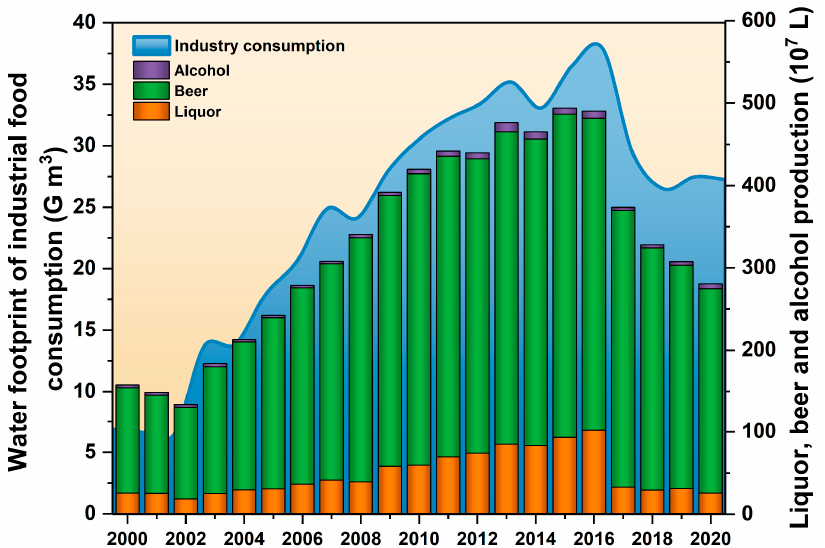
Figure 7. Water footprint of industrial grain consumption in Northwest China, 2000–2020. Note: The data of liquor, beer and alcohol in the statistical analysis results are shown according to volume. According to their density differences, we multiplied their volume unit values by 0.89, 1.0 and 0.8, respectively, into mass units. Industrial consumption involves liquor, beer, alcohol and side food. Their conversion coefficients to grain are 2.33, 0.15, 2.80 and 1.20, respectively [38,39].